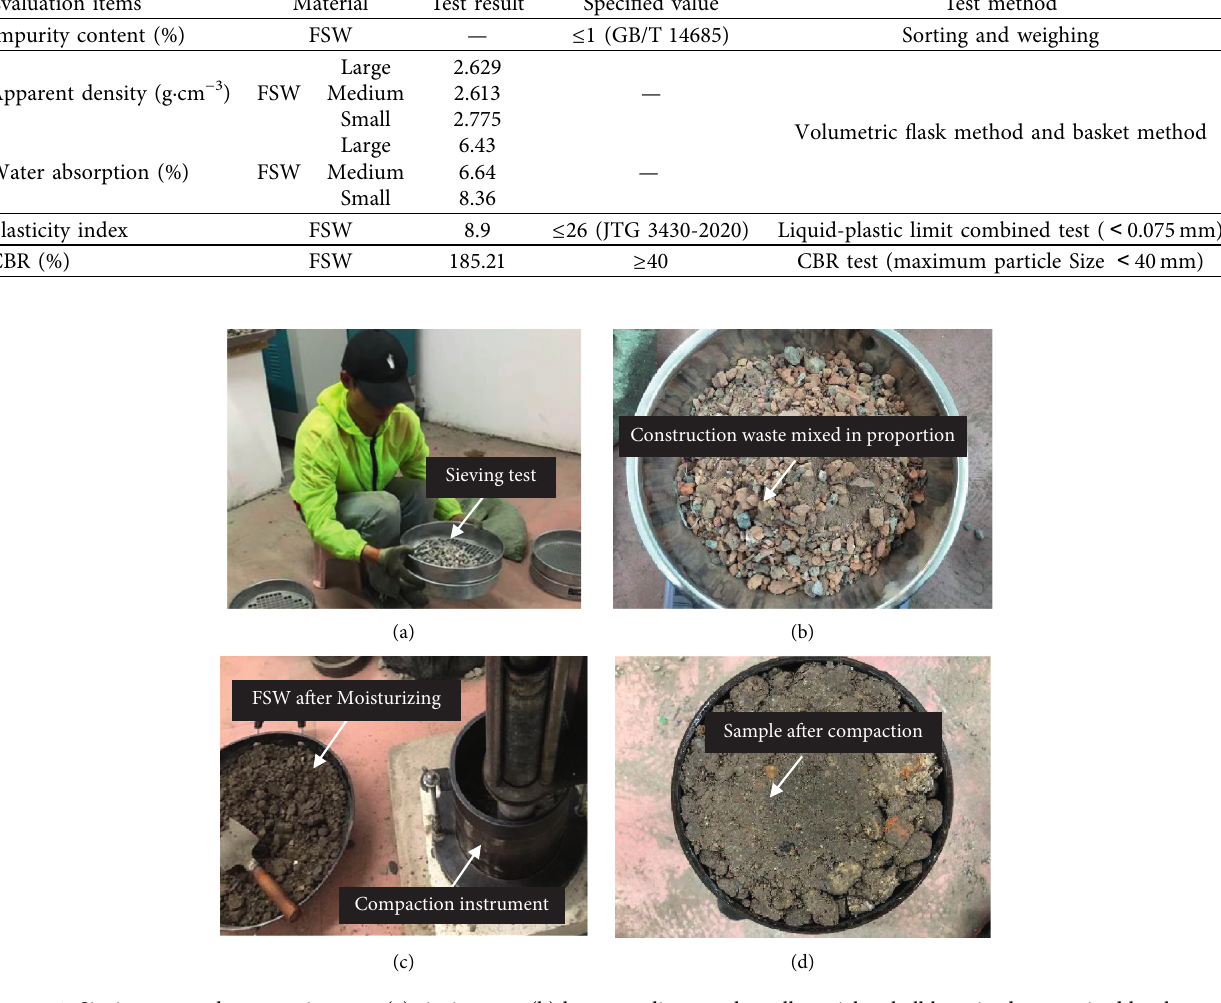
Figure 1: Sieving test and compaction test: (a) sieving test; (b) large, medium, and small particles shall be mixed as required by the test; (c) compaction test; (d) sample after compaction.